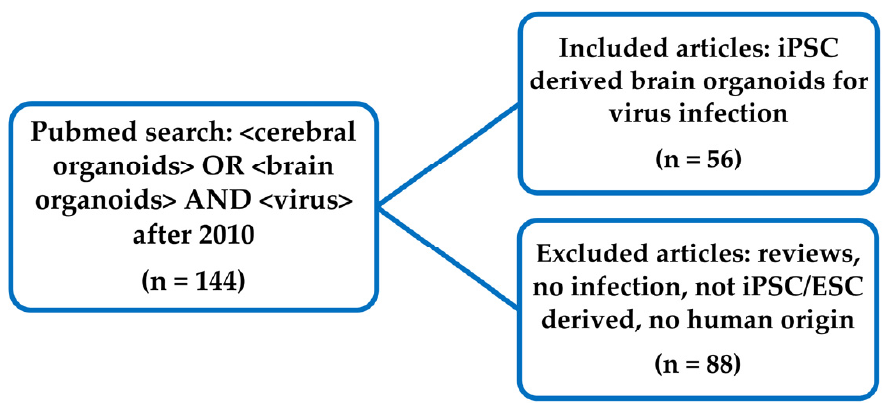
Figure 1. Flow diagram of included articles. Articles were included that used brain organoids derived from induced pluripotent stem cells (iPSCs) or human embryonic stem cell (ESCs) for studying viral infection.